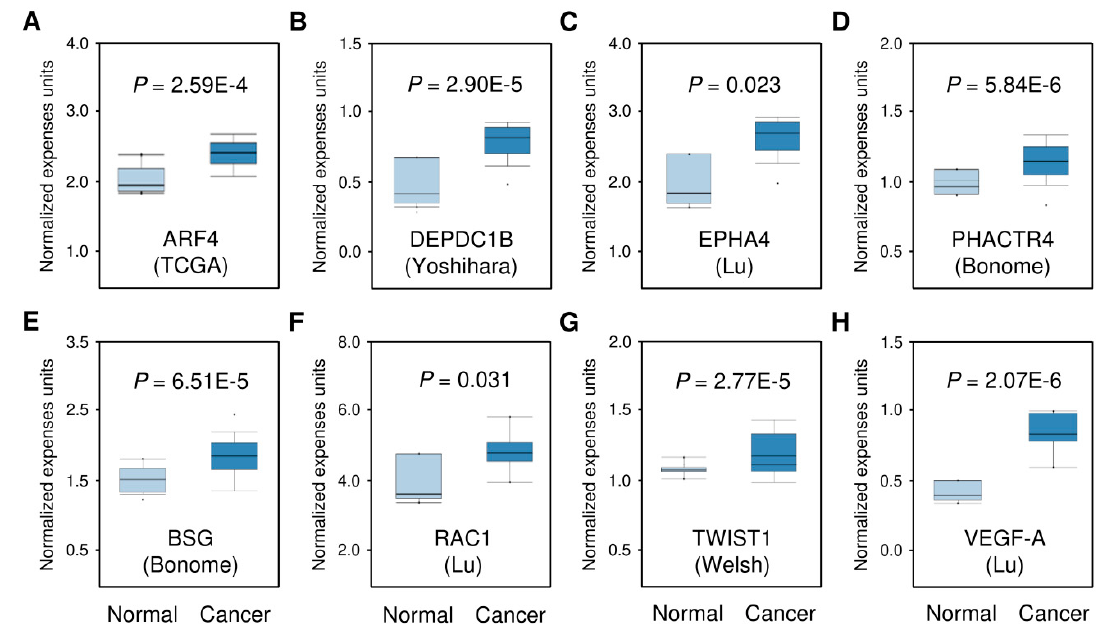
Figure 4. Oncomine analysis indicates higher expression of the predicted miR-361 targets in ovarian cancer tissues. The box plots revealed the expression levels of ARF4 ( A , The Cancer Genome Atlas (TCGA)), DEPDC1B ( B , Yoshihara), EPHA4 ( C , Lu), PHACTR4 ( D , Bonome), BSG ( E , Bonome), RAC1 ( F , Lu), Twist ( G , Welsh) and VEGF-A ( H , Lu) in ovarian cancer tissues with respect to normal tissues. P -values were calculated using the Oncomine database through two-sided Student’s t -test. A value of p < 0.05 was considered as statistically significant.